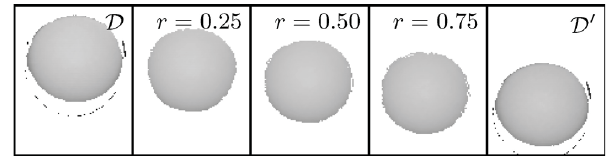
Fig. 4 Depth interpolation. Three interpolated depth maps with interpolation ratios of 0 . 25, 0 . 50, and 0 . 75 are generated from input depth maps D and D (cid:2)